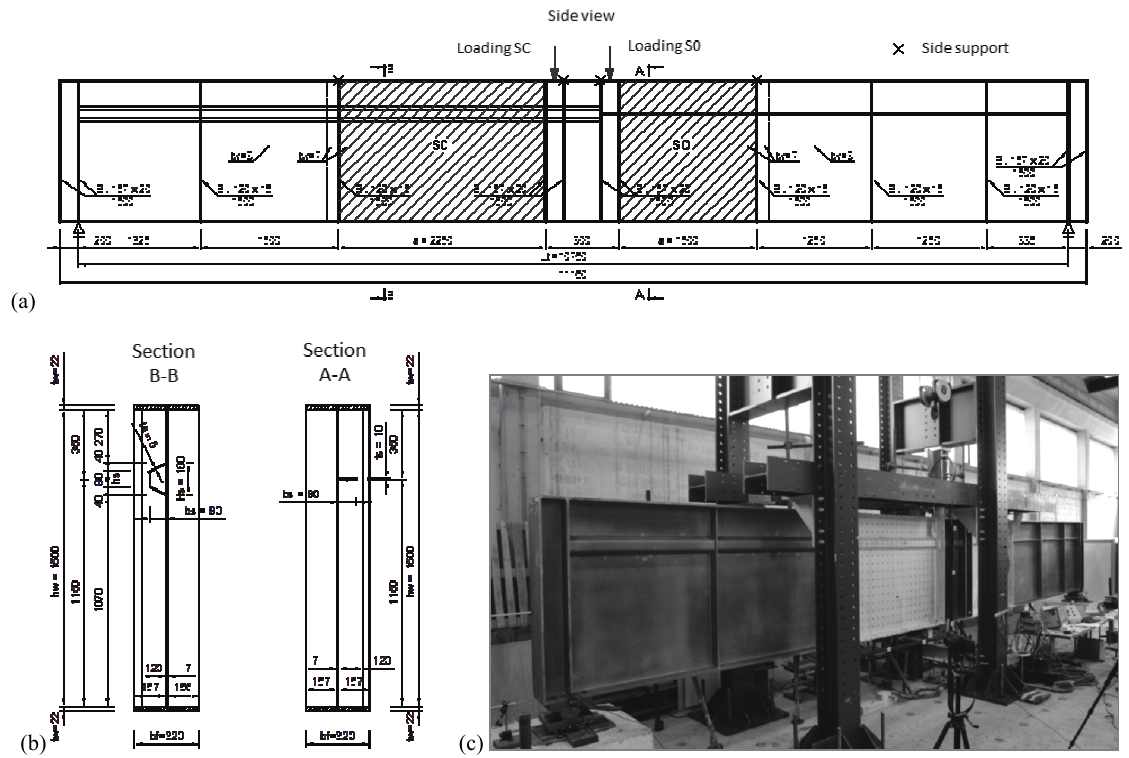
Fig. 5. Test stand and basic dimensions of analyzed girder (Sinur [10])